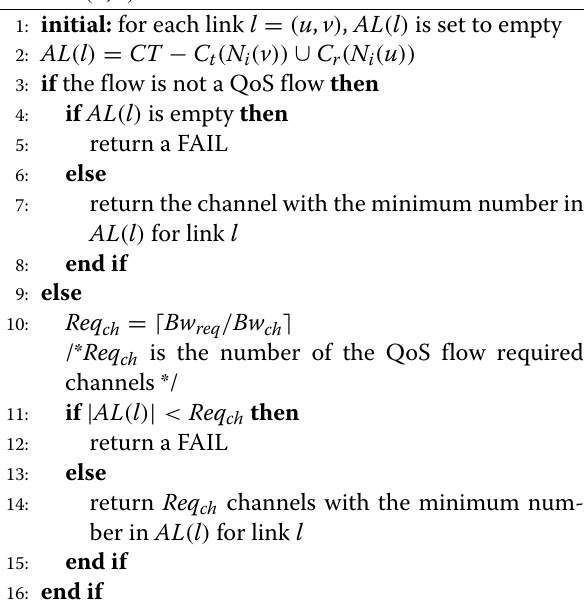
Algorithm 1 Channel Assignment Algorithm(CA) for